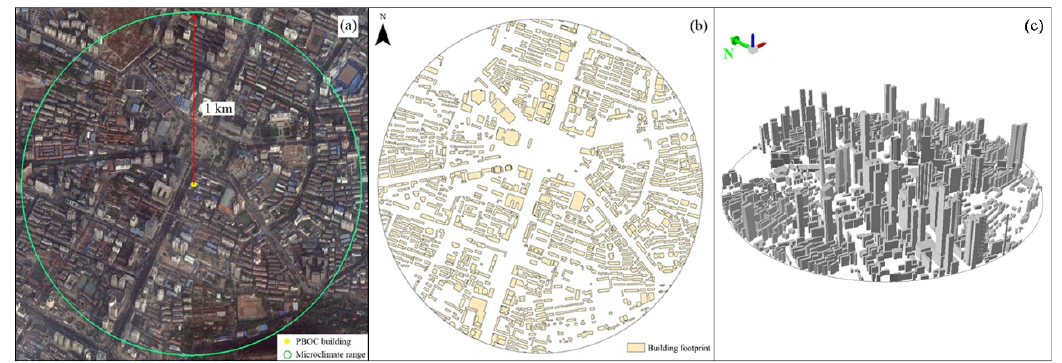
Figure 3. Diagram of the 1 km buffer for a PBOC building ( a ), 2D pattern of the buildings in the buffer area ( b ), and 3D form (displayed after stretching) of the buildings in the buffer area ( c ).